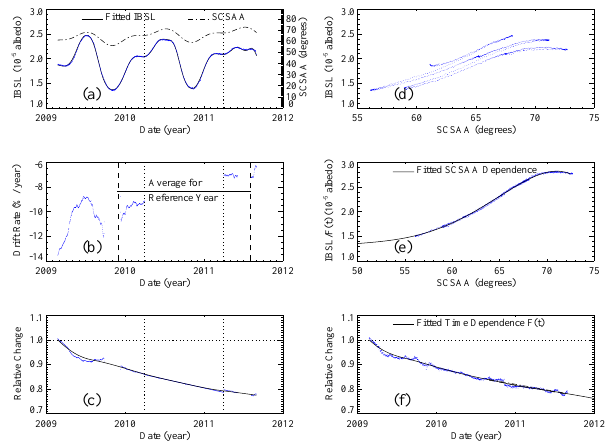
Fig. 9. N19 IBSL at 273nm at SCSEA = 18 ◦ is a product of time dependence and SCSAA dependence. (a) Daily IBSL values (blue dots for raw data) are highly correlated with SCSAA (dashed curve), and can be represented by F(t) × G (SCSAA) (solid curve). (b) Average drift rates are derived from comparison of daily IBSL values at the same SCSAA. Missing data are due to SCSAA values outside the range in the reference period. (c) Initial estimate of IBSL time dependence is derived from the comparison of daily IBSL val- ues at the same SCSAA, and from the average drift rate for the ref- erence period. It is smoothed and interpolated with piecewise linear fit. (d) Daily IBSL values before removing the time dependence are plotted against SCSAA at SCSEA = 18 ◦ . (e) IBSL/ F(t) is fitted with a polynomial of SCSAA, G (SCSAA). (f) Relative changes are reiterated with daily IBSL values divided by the fitted G (SCSAA), then normalized and smoothed for the time dependence function, F(t)